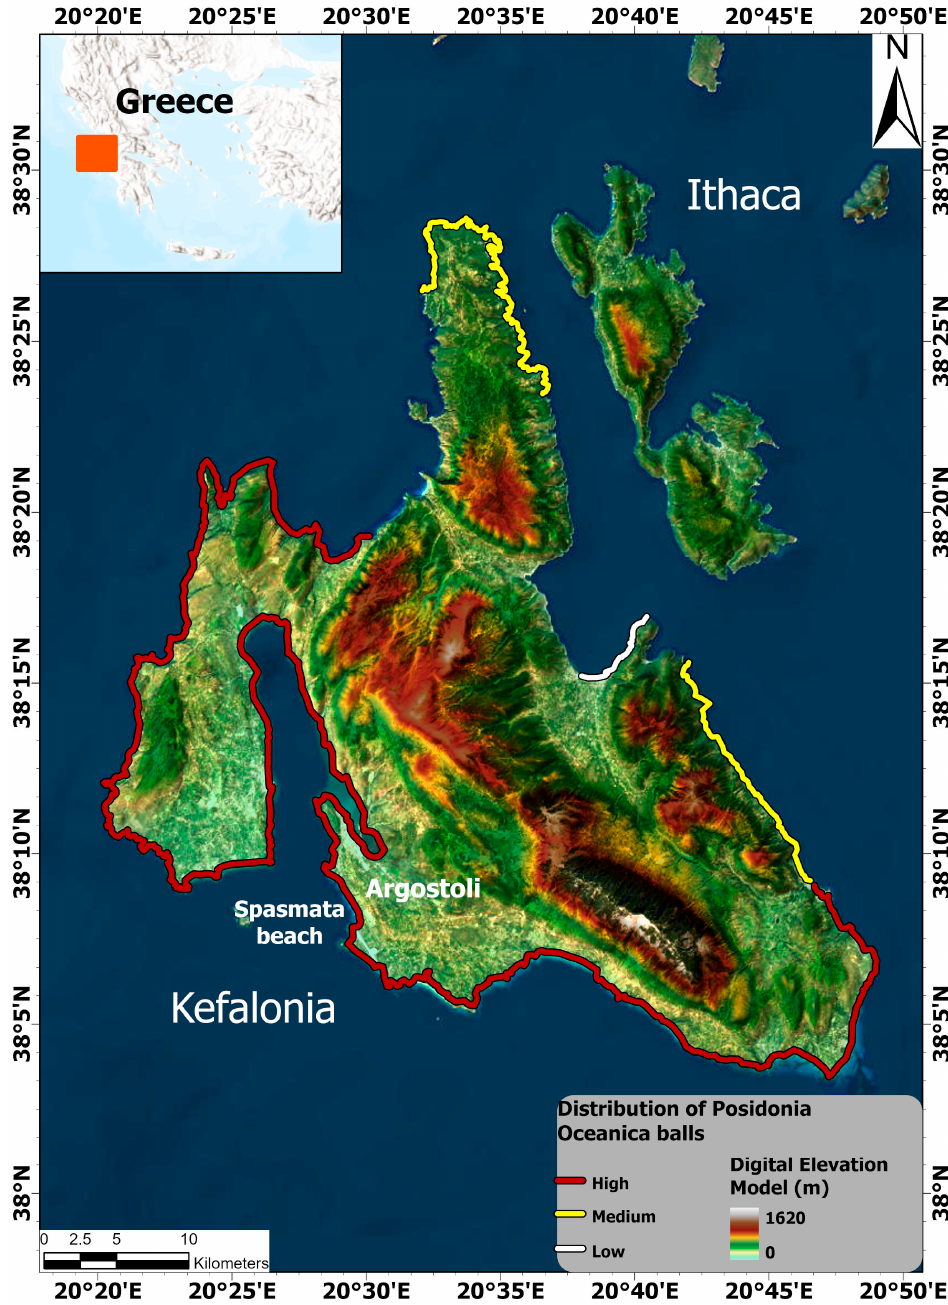
Figure 3. Spatial distribution of Posidonia oceanica balls in Kefalonia Island after fieldwork. Source base map: ESRI world imagery.